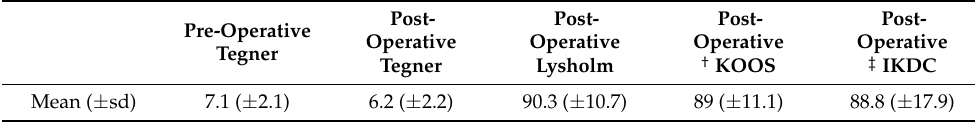
Table 2. Summary of patient reported outcome